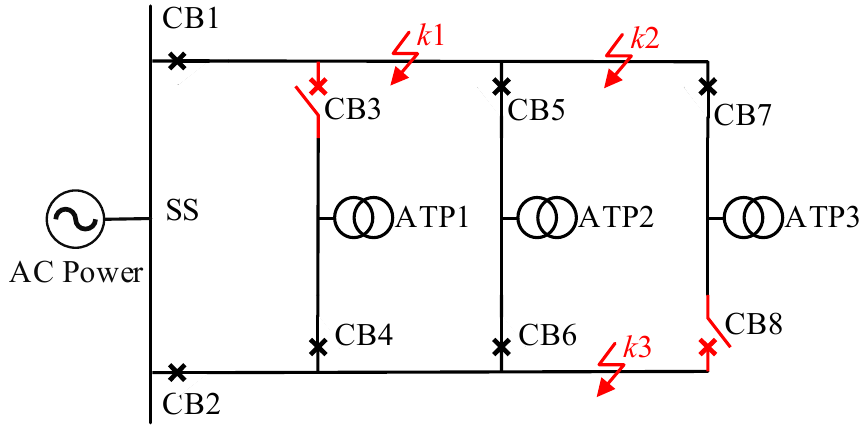
Figure 10. Simulated railway system.